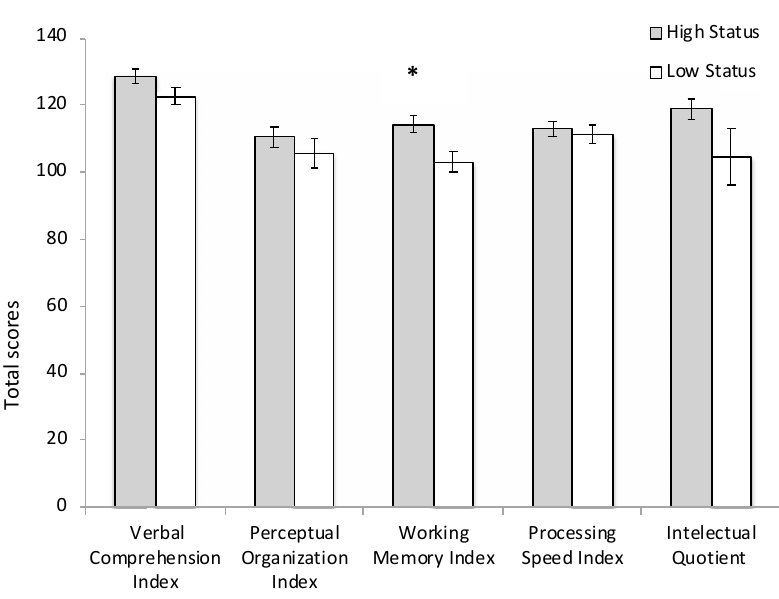
Figure 4. Total normalized scores by high and low status groups in each index and total IQ. * p = 0.009.